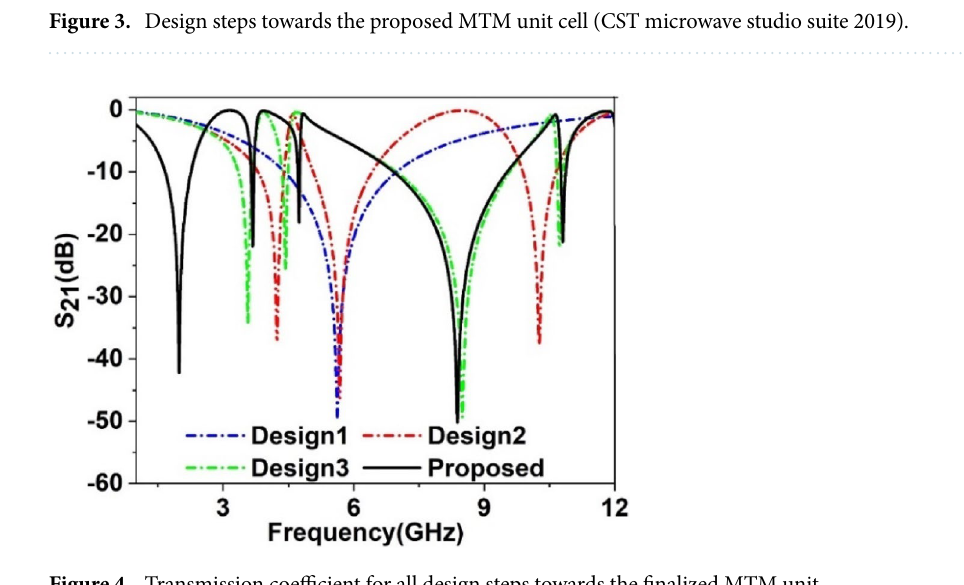
Figure 4. Transmission coefficient for all design steps towards the finalized MTM